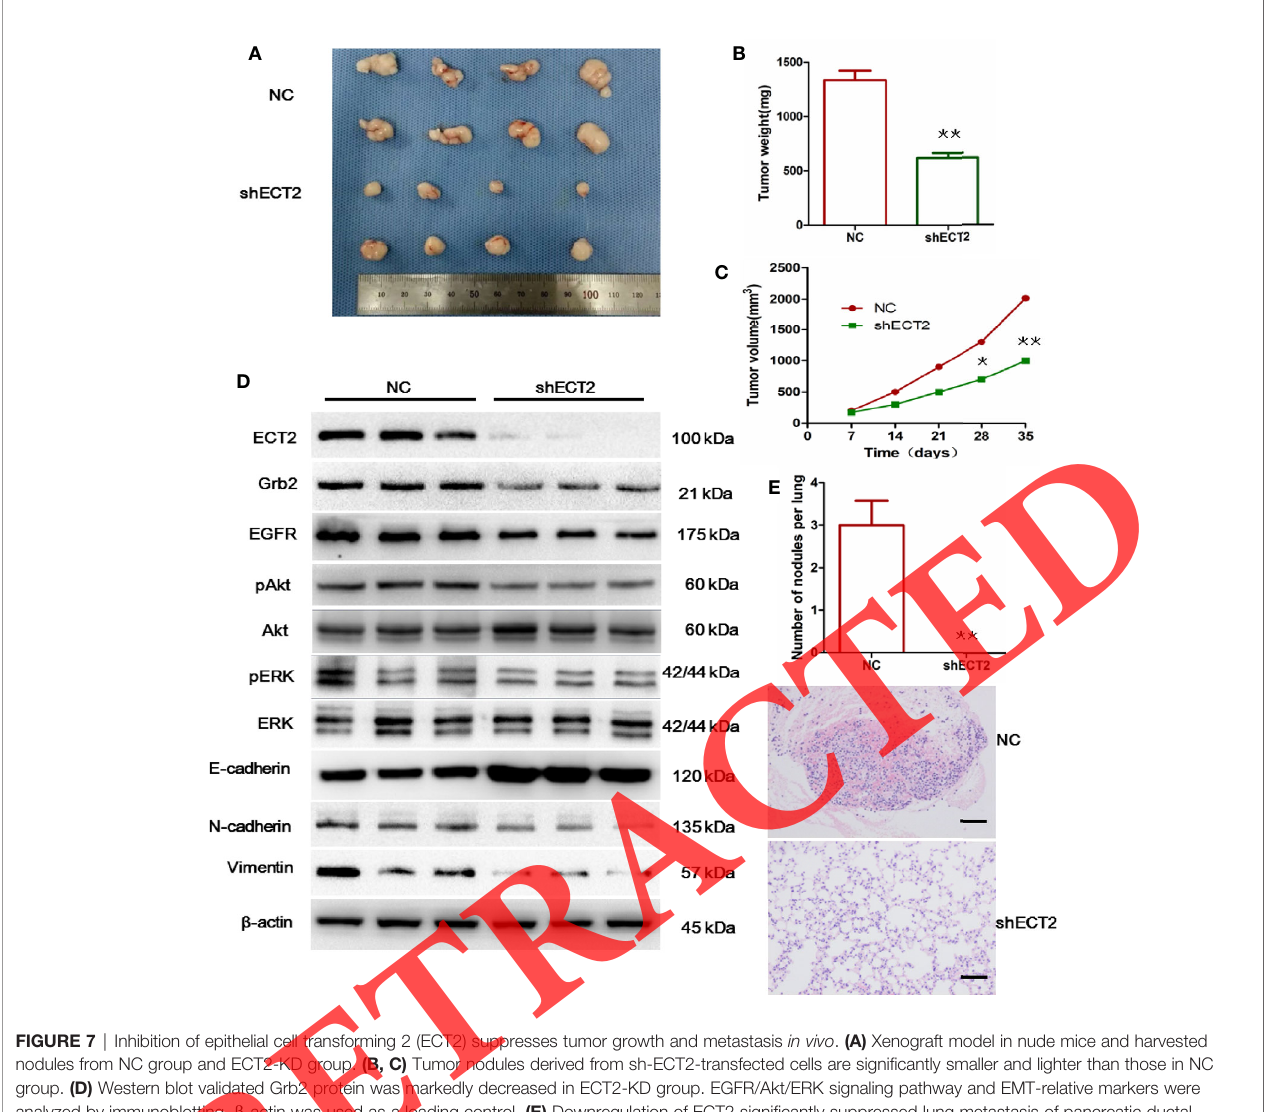
FIGURE 7 | Inhibition of epithelial cell transforming 2 (ECT2) suppresses tumor growth and metastasis in vivo . (A) Xenograft model in nude mice and harvested nodules from NC group and ECT2-KD group. (B, C) Tumor nodules derived from sh-ECT2-transfected cells are signi fi cantly smaller and lighter than those in NC group. (D) Western blot validated Grb2 protein was markedly decreased in ECT2-KD group. EGFR/Akt/ERK signaling pathway and EMT-relative markers were analyzed by immunoblotting. b -actin was used as a loading control. (E) Downregulation of ECT2 signi fi cantly suppressed lung metastasis of pancreatic ductal adenocarcinoma (PDAC) cells. Scale bar: 200 m m. * p <0.05, ** p